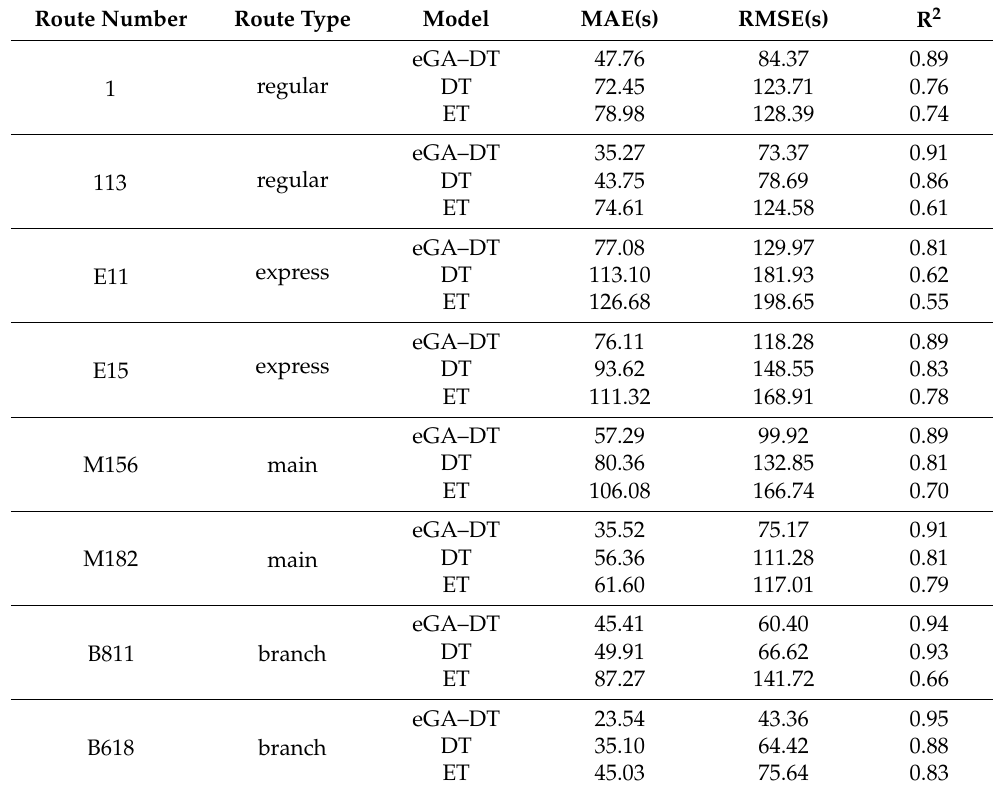
Table 5. Model performance by eGA–DT, DT, and ET for different bus